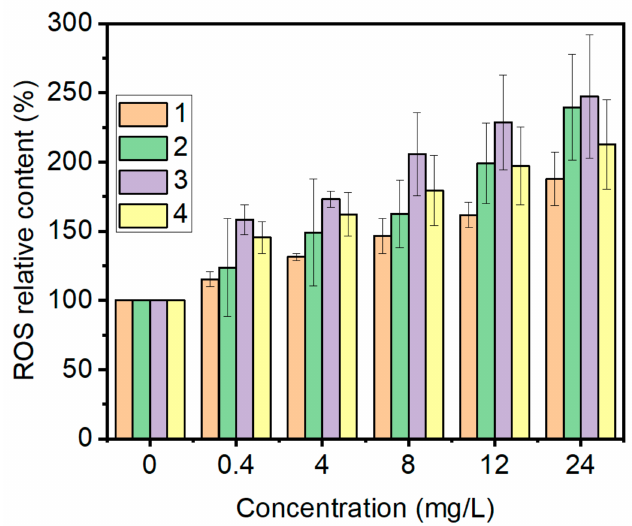
Figure 11. Intracellular reactive oxygen species (ROS) induced by Cu-VO in the M. aeruginosa cells. ROS assay was performed three times, and the plot was the average of three independent